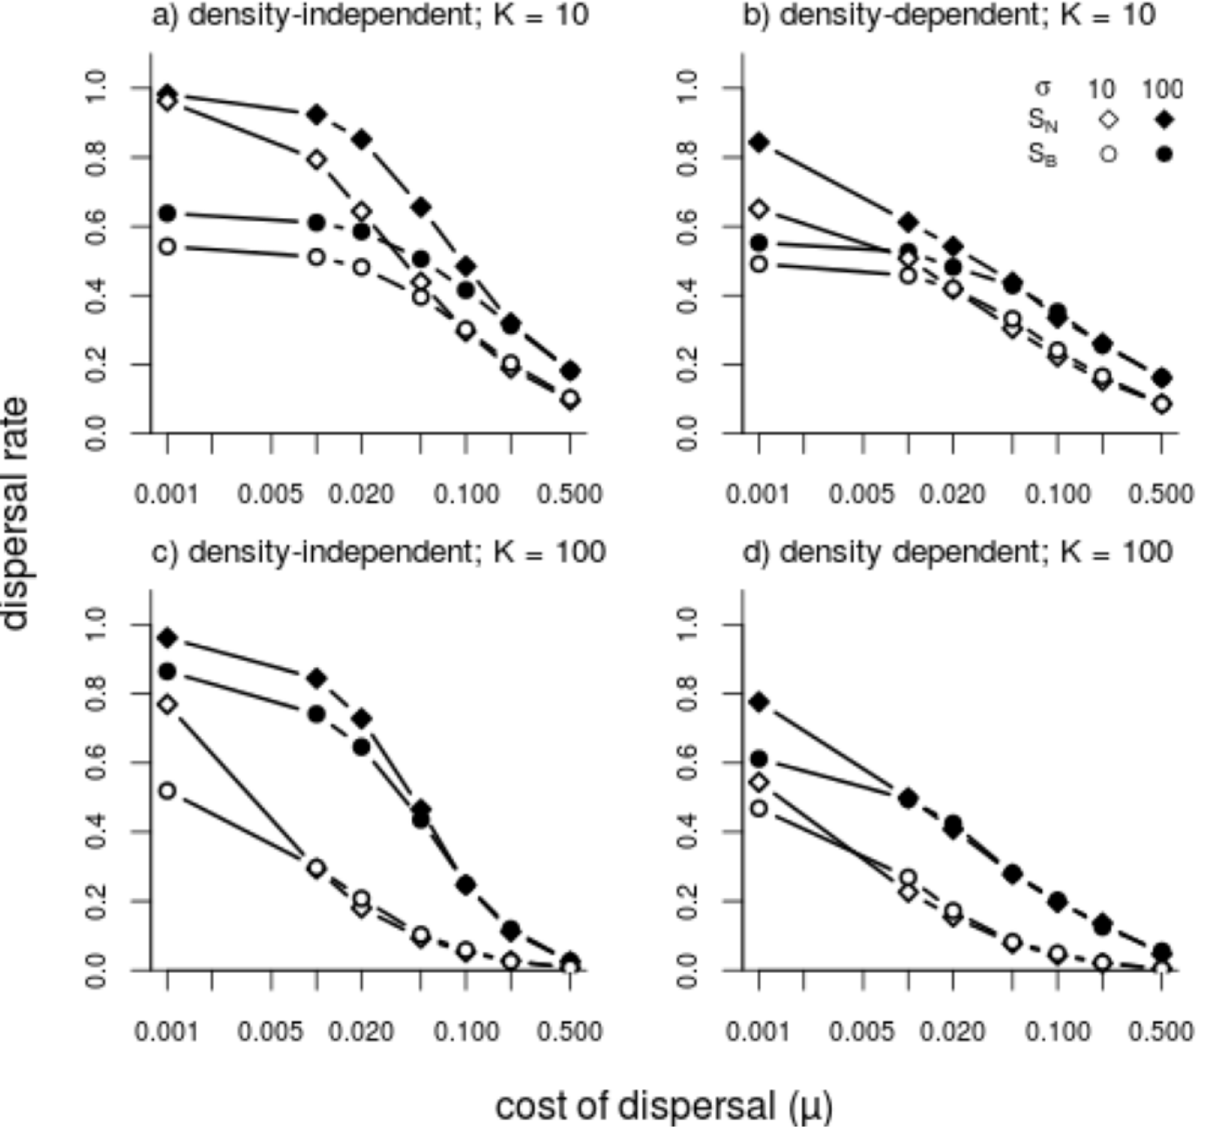
Fig 4. The effect of environmental variance ( σ )), patch capacity ( K ) and dispersal costs ( μ ) on evolved dispersal rates. Density-independent (DI) dispersal (graphs a,c) and density-dependent (DD) dispersal (graphs b,d). Small carrying capacity ( K = 10, graphs a,b) and big carrying capacity ( K = 100, graphs c,d). Empty symbols ( σ = 0) and filled symbols ( σ = K). Diamonds and circles stand for S N and S B